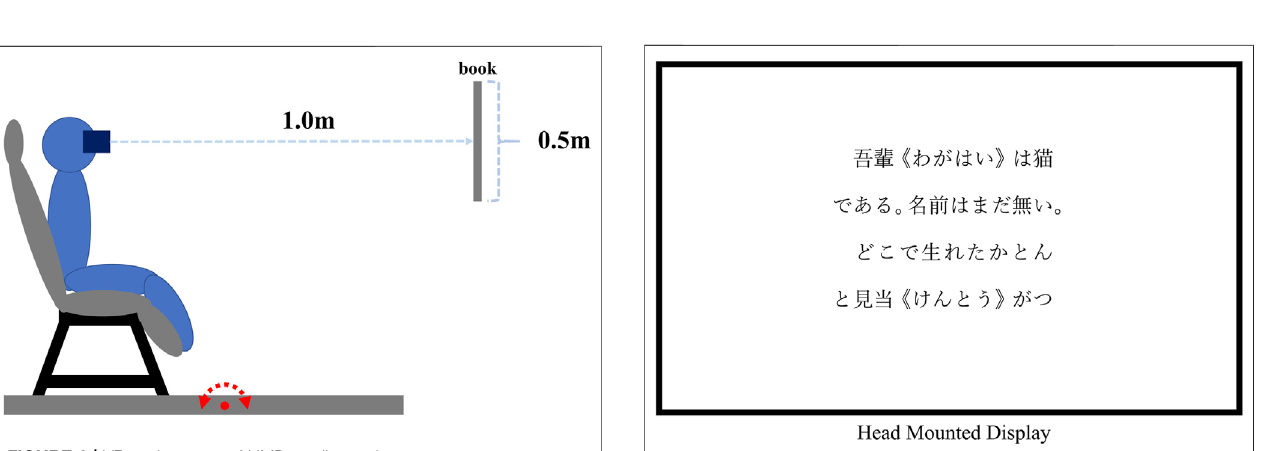
FIGURE 2 | Target angle in the pitch direction of the vibration device.